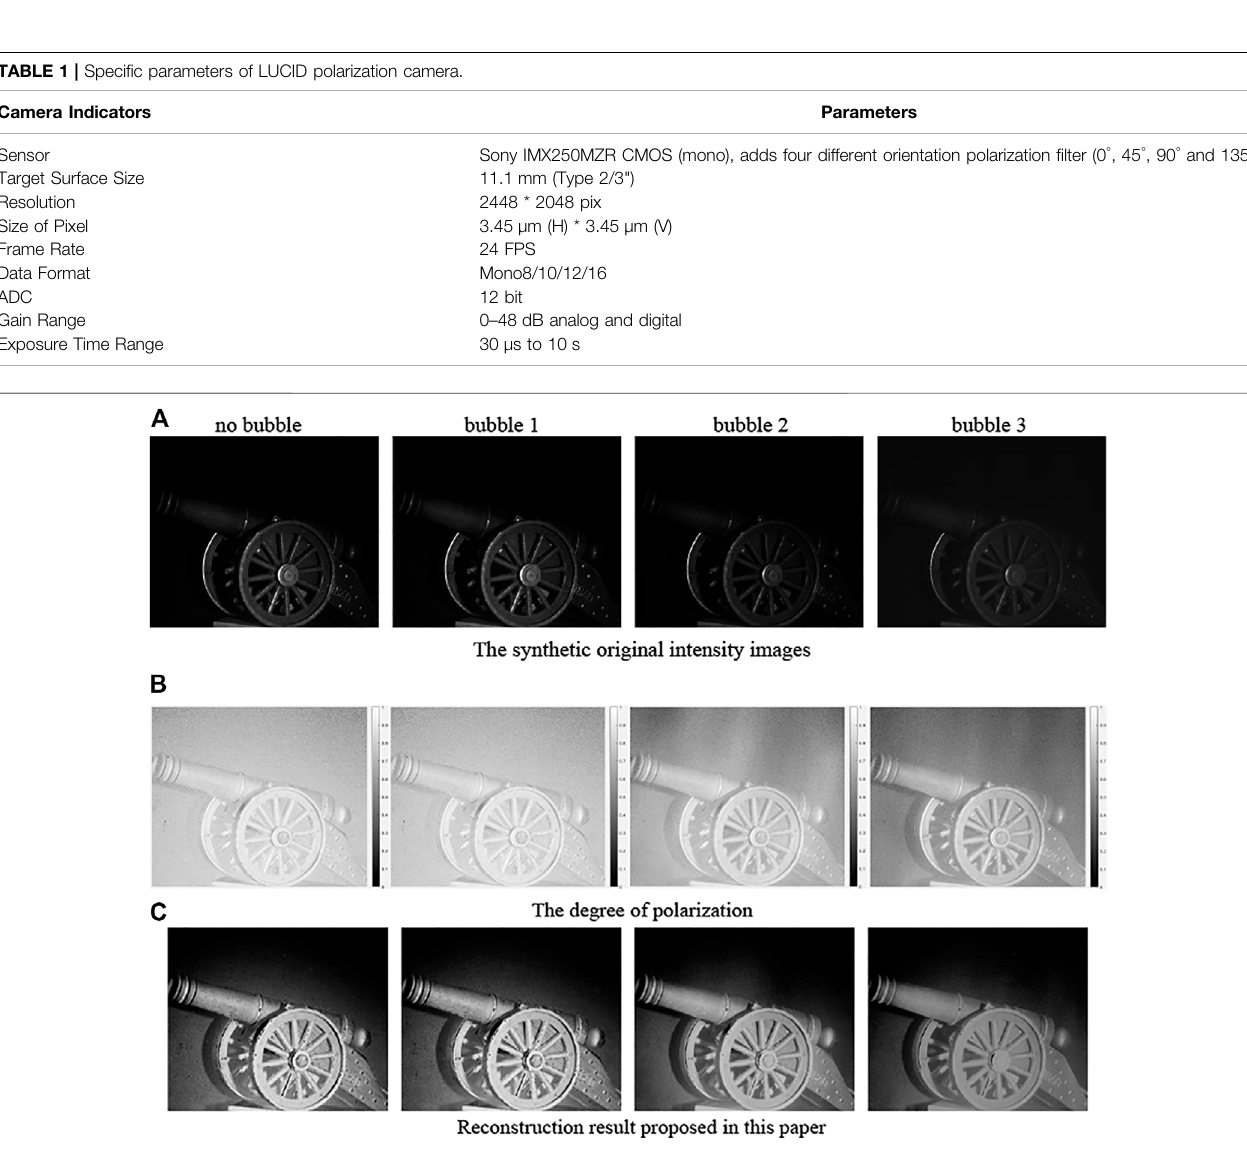
FIGURE 12 | Effects of different density of bubble on target polarization imaging. (A) The synthetic original intensity images. (B) The degree of polarization. (C) Reconstruction result proposed in this paper.